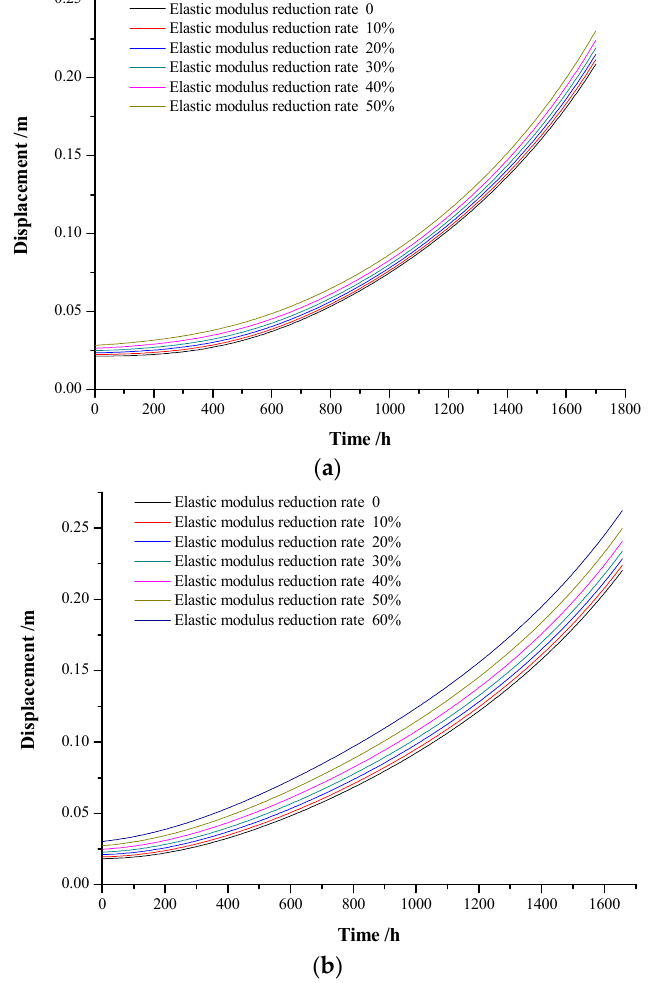
Figure 12. Variation of perimeter displacement with elastic modulus of primary support. ( a ) D3 monitoring point. ( b ) D6 monitoring point.